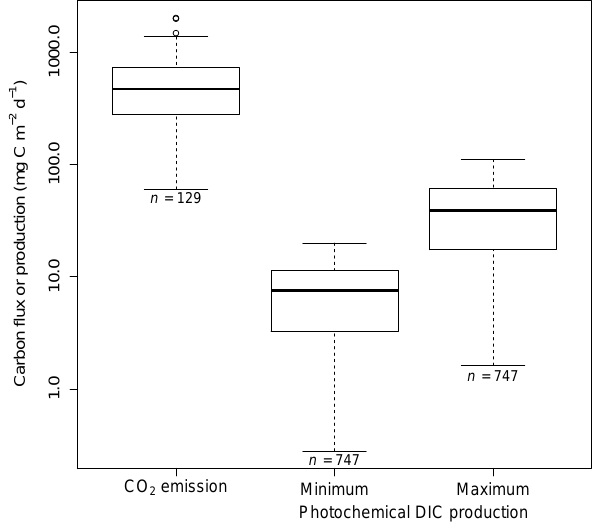
Figure 5. Box-and-whiskers plots of total measured CO 2 emissions, and minimum and maximum simulated photochemical DIC pro- duction, showing the median and first and third quartiles with the whiskers set at ± 1.5 times the interquartile range and data outside this range given as circles. Note the log scale on the y